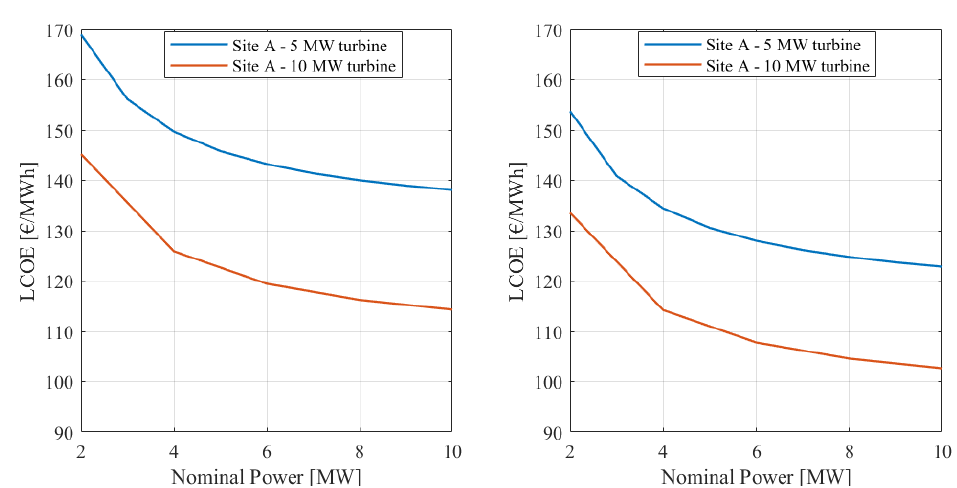
Figure 21. Comparison between 5 MW and 10 MW wind turbine for site A.